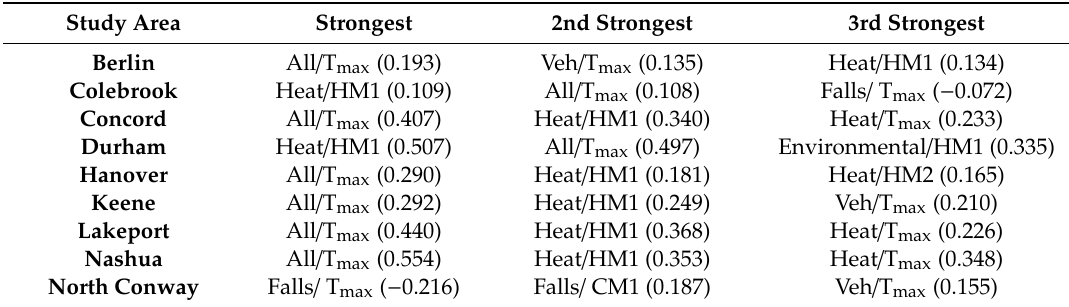
Table 6. Strongest correlations for each study area with the outcome variable listed first and the exposure variable listed second.